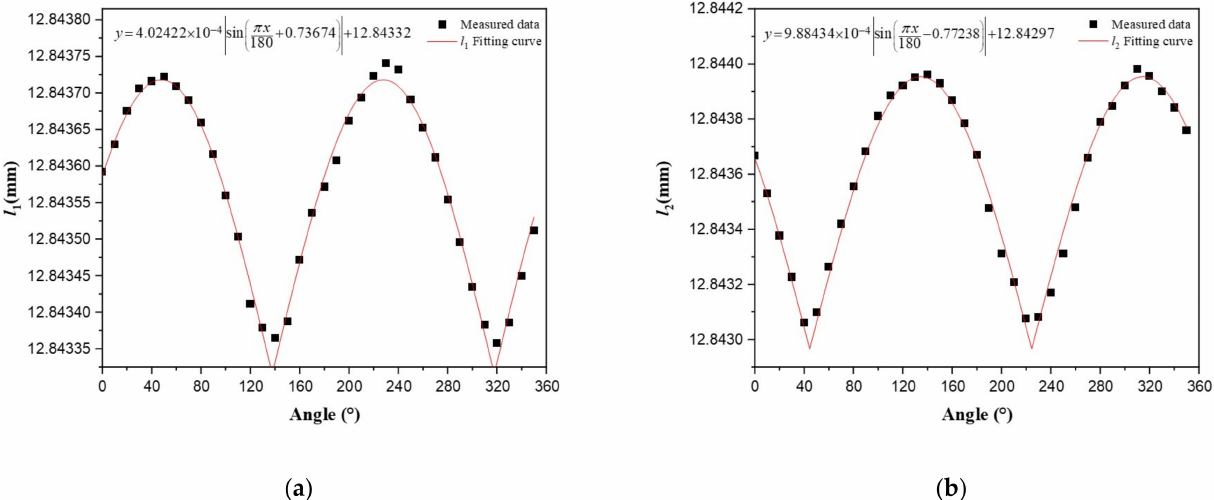
Figure 10. The measured relationship of cavity length of CFBG-FP vs. the angle of the adjustable stage. ( a ) Cavity length of CFBG-FP1 vs. the angle of the adjustable stage. ( b ) Cavity length of CFBG-FP2 vs. the angle of the adjustable stage.